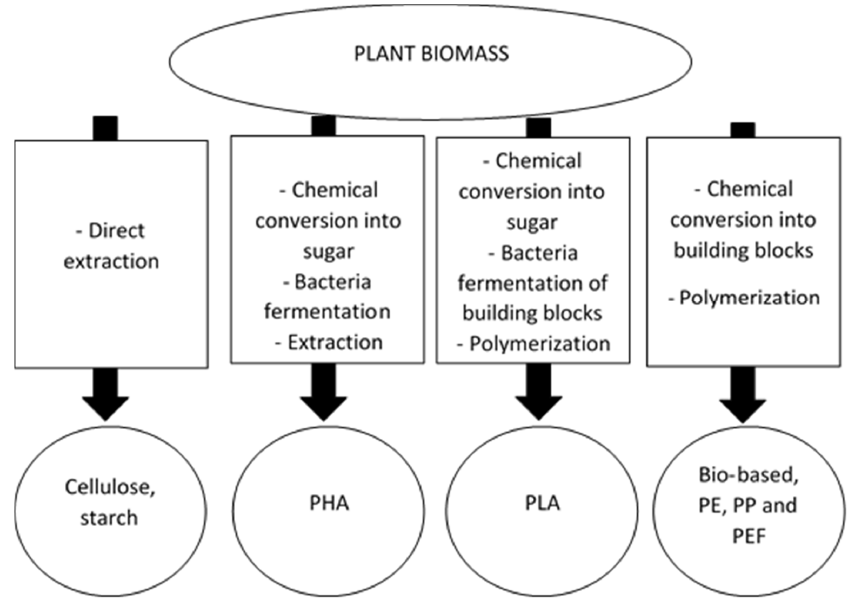
Figure 1. Bioplastic processing routes dependent on plant biomass. Data adapted from [20].